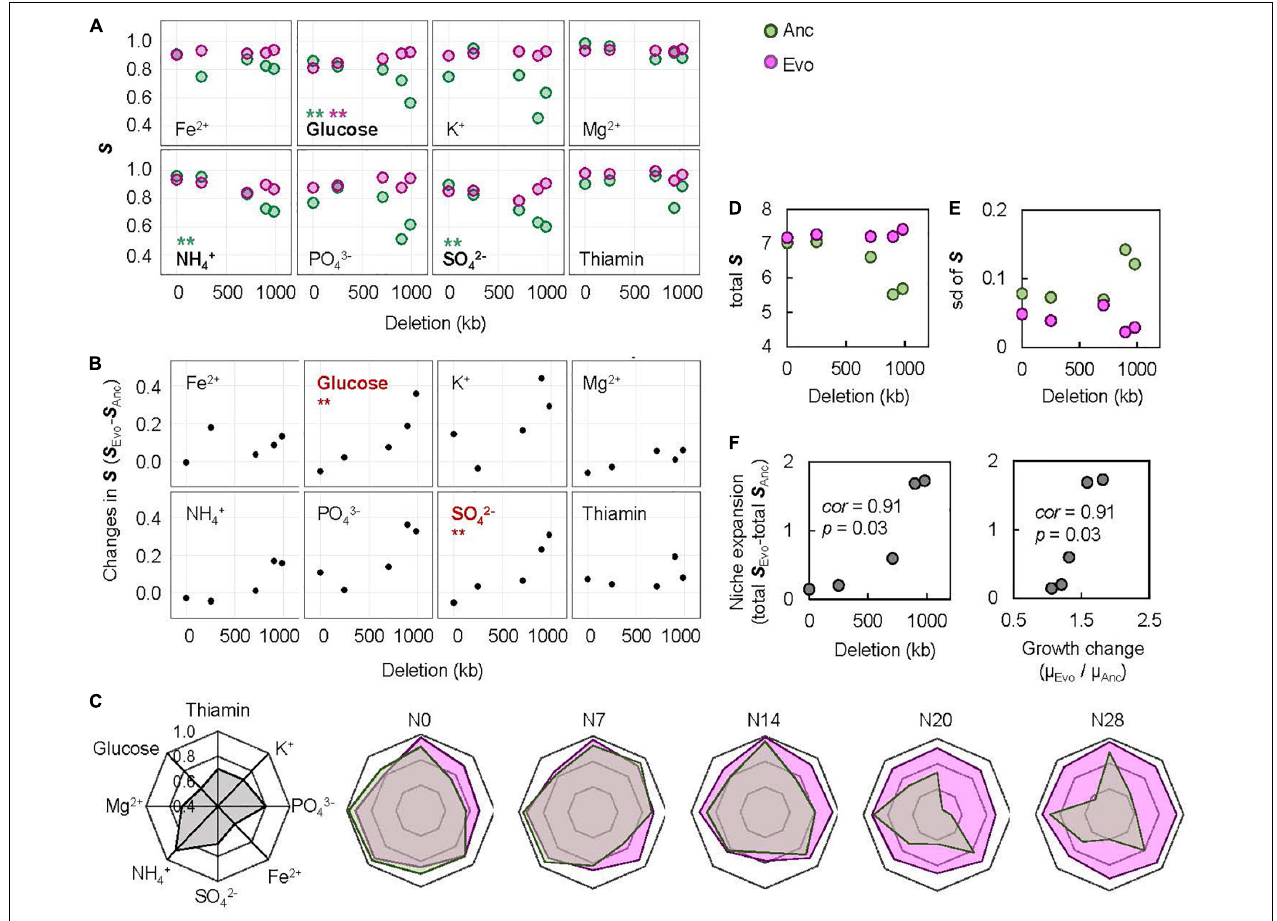
FIGURE 5 | Evaluation of the breadth of adaptation. (A) Relationships between the S and genome reduction. The chemical niches and the statistical significance of the Spearman rank correlation are indicated. Boldfaces associated with asterisks represent statistical significance (** p < 0.01). Pink and green represent Evo and Anc, respectively. (B) Relationships between the changes in S and genome reduction. The chemical niches and the statistical significance of the Spearman rank correlation are indicated. Boldfaces in red associated with asterisks represent statistical significance (** p < 0.01). (C) Radar chart of the eight niche spaces. The eight chemical niches and the scale of S are illustrated in the monotone radar chart. The five genomes are shown separately. Transparent pink and green represent Evos and Ancs, respectively. (D) Sum of the eight S . (E) Standard deviation of the eight S . (F) Correlation of the changes in total S to genome reduction and direct adaptation. The Spearman rank correlation coefficients and statistical significance are